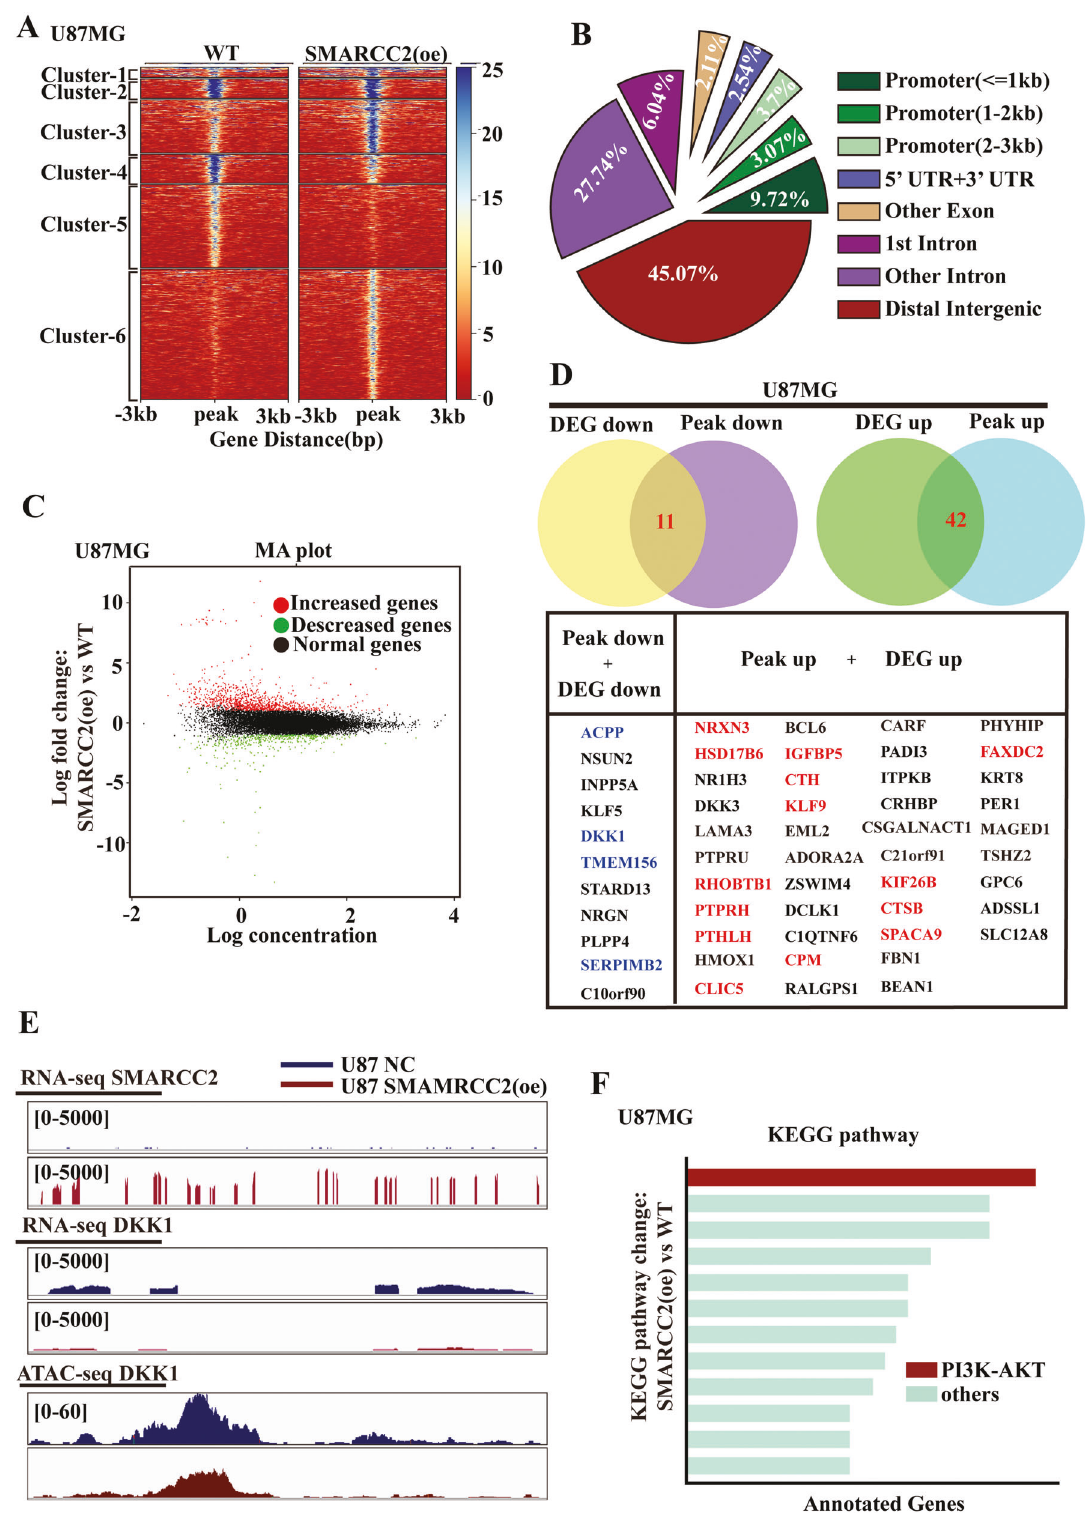
Fig. 2 SWI/SNF alters cellular chromatin polarity. A ATAC-seq read-density heatmaps from U87MG cells overexpressing SMARCC2 for indicated durations ( n = 2 biological replicates). B Genome-wide annotation of chromatin accessibility after overexpression of SMARCC2 in U87MG cells. C RNA-seq MA plot showing up (red)- and down (green)-regulated genes in the genome upon overexpression of SMARCC2 in U87MG cells. D Combined analysis of ATAC-seq and RNA-seq data to screen for genes with downregulated mRNA expression and reduced chromatin polarity (above, left), and another part of genes with upregulated mRNA expression and increased chromatin polarity (above, right). Speci fi c gene names were presented in tabular form (under). E Representative screenshot in U87MG cells showing obviously changes in DKK1 upon SMARCC2 overexpression. F KEGG enrichment analysis of the above-changed genes.